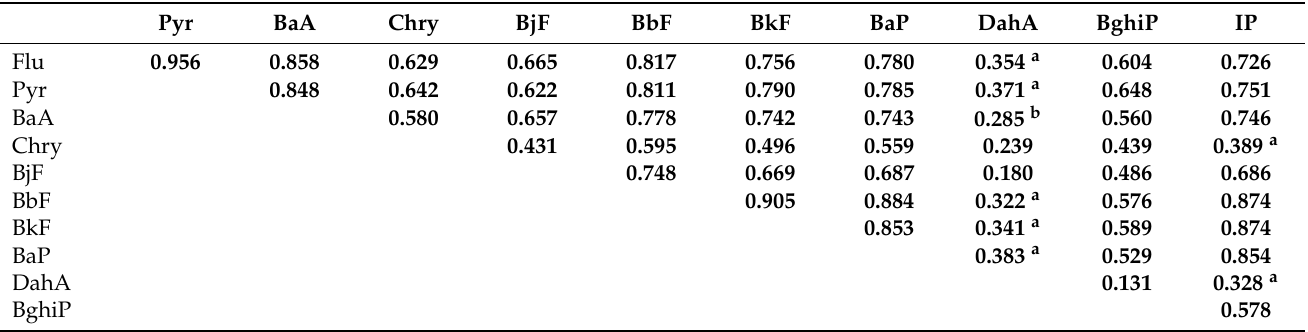
Table 3. Spearman correlation coefficients (r) between mass fractions of PAHs detected in